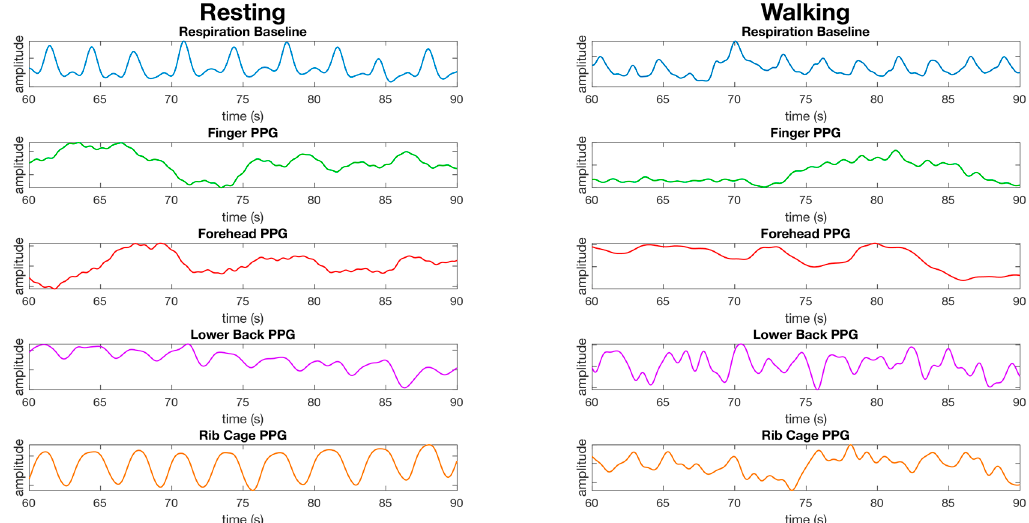
Figure 8. Comparison of the processed waveforms used for calculating respiration from the finger, forehead, lower back, and rib cage from a male dataset while resting (left) and while walking (right). The data is presented as the same randomly selected 30 s window of data from the same dataset for all resting waveforms, and the same dataset for walking waveforms. No synchronization of waveforms has been performed, the waveforms are presented as recorded bar processing as described in the material and methods section. The y-axis units are arbitrary as we are not comparing the amplitude of waveforms, but the average time between peaks over a window of data. Table 5. Median error for respiration calculation at eight anatomical location using the red and infrared channels at rest and walking. Median error is presented as the respirations per minute (rpm) deviation from the respiration shirt baseline data. Wrist refers to the posterior distal forearm. Neck refers to the back of the neck. L Back refers to lower back. Respirations per minute is denoted as rpm. Location